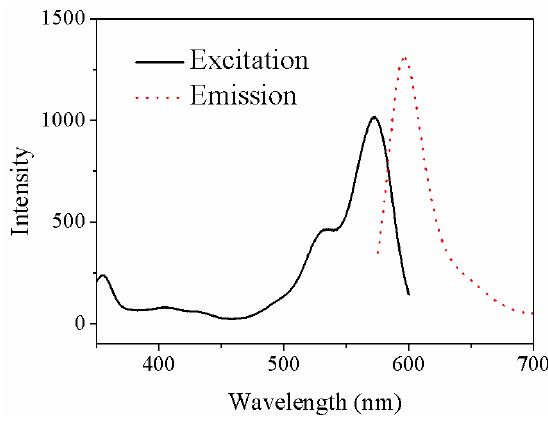
Figure 6. The absorption spectrum and emission spectrum of RRA-DNA fragment .